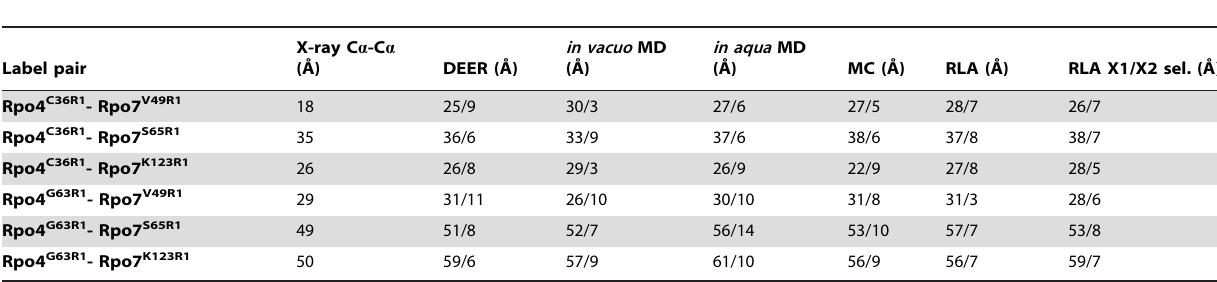
Table 4. Comparison of experimental and calculated mean distances for spin label pairs.